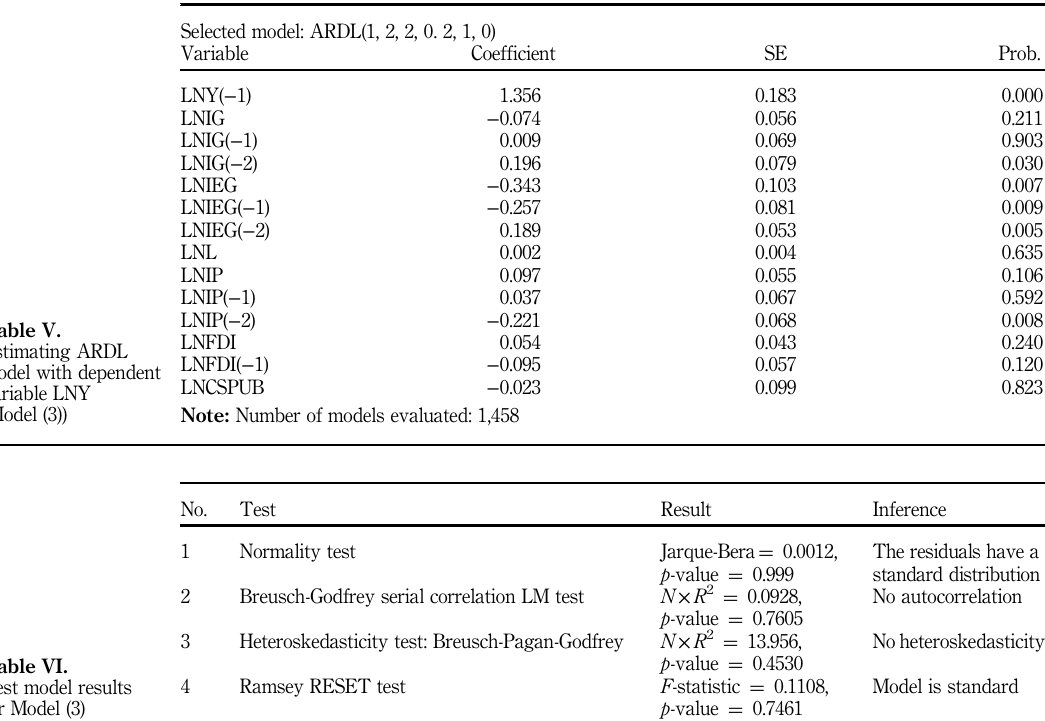
Model is standard